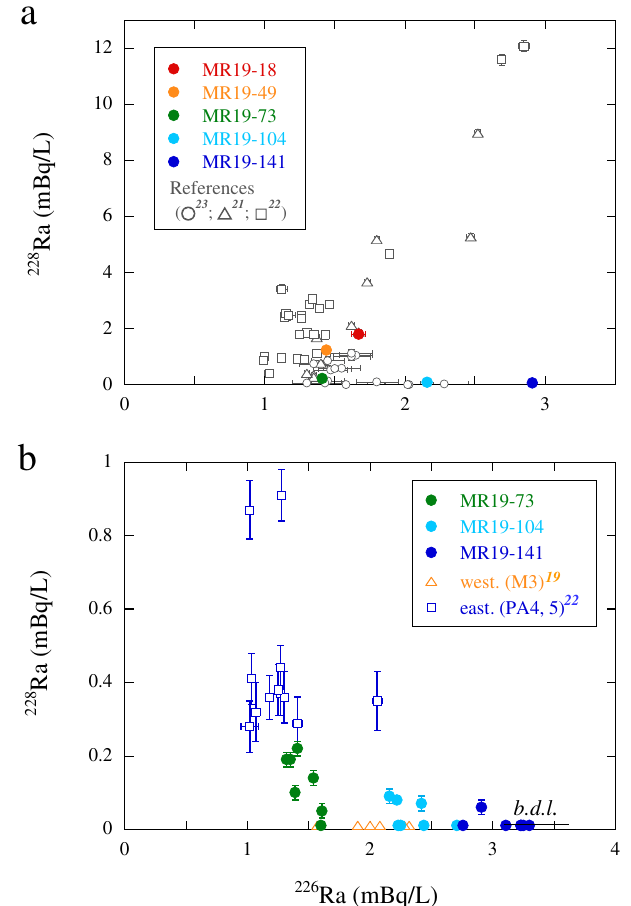
Figure 5. 226 Ra versus 228 Ra concentrations of waters from ( a ) the surface (depth ≤ 10 m) and ( b ) surface to a depth of 800 m, along with data from previous studies in the Indian and Southern Oceans 19,21–23 .